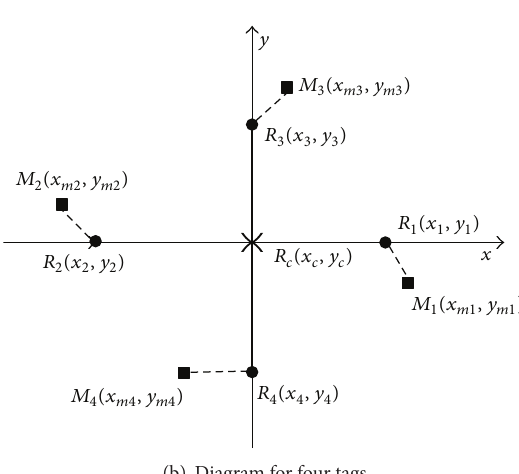
centroid of the tags being used. In this approach, the filters were applied to each tag, and only in step 4 is the centroid determined, based on the filtered 𝑀 𝑖 values.